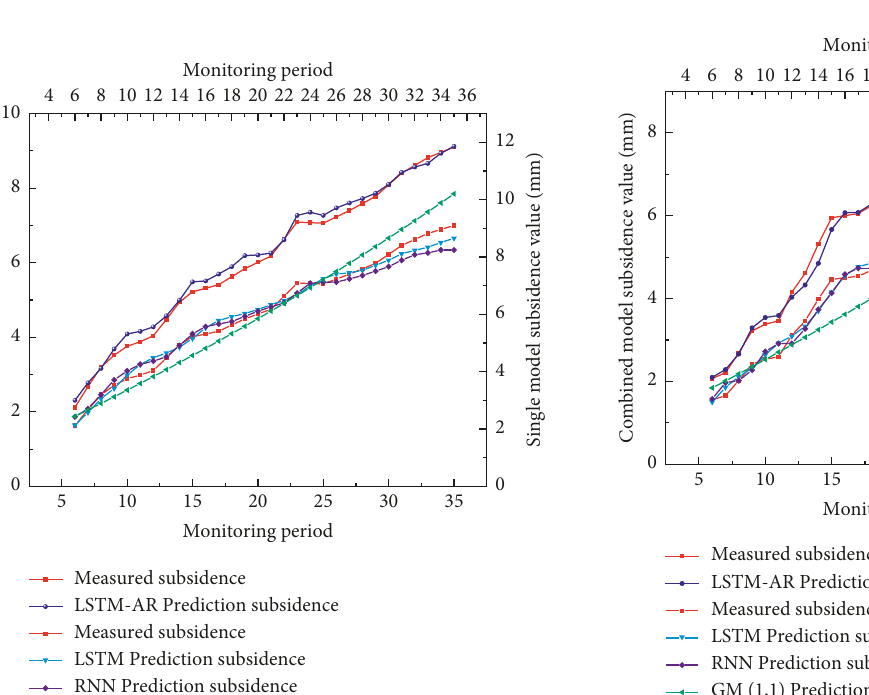
Figure 8: KQ2-Z prediction result.